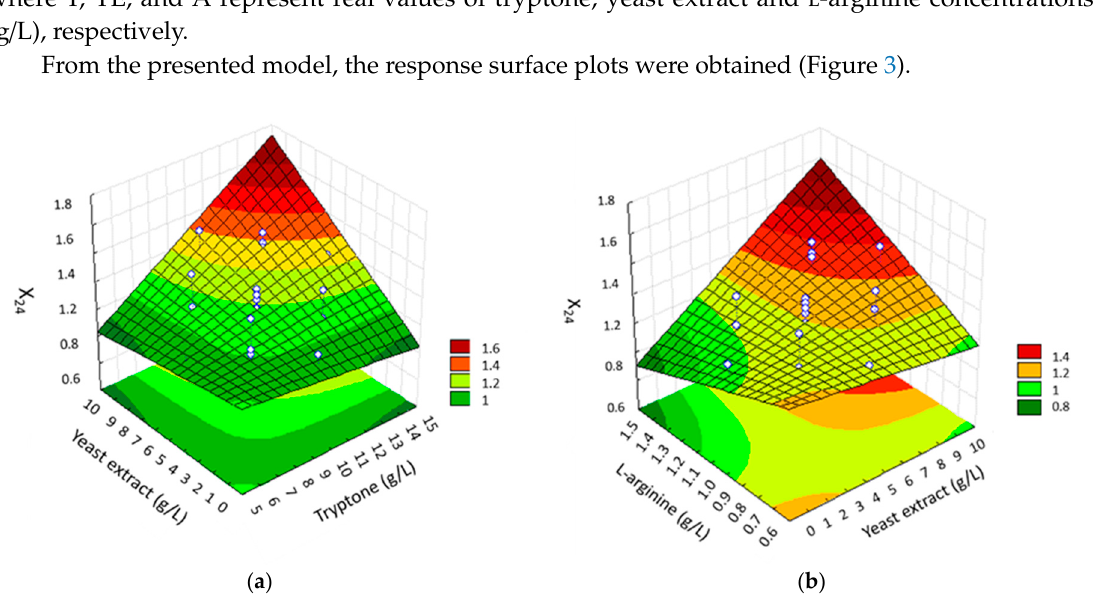
Table 5. Biomass production in syngas fermentation by Clostridium carboxidivorans after 24 h.